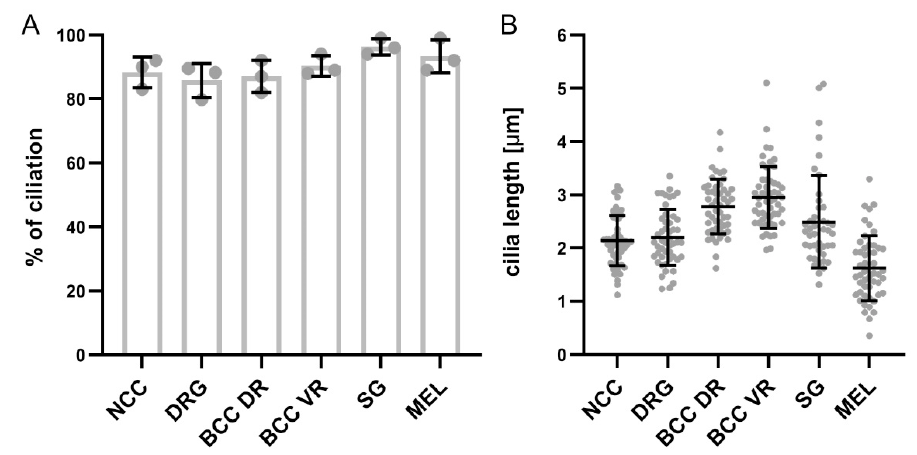
Figure 5. Quantification of the percentage of ciliated cells and ciliary length in NCCs and their derivatives. ( A ) Graph showing the average percentage of ciliation in migrating NCCs at HH18 and NCC derivatives at HH26. Note that for DRG, the average percentage of Hoechst-positive cells bearing a cilium is shown. ( B ) Graph showing the average cilia length in migrating NCCs at HH18 and NCC derivatives at HH26. Error bars represent standard deviation. Data points represent the average percentage for each embryo ( A ) and single data points of cilia length that were measured ( B ), respectively. DR, dorsal roots; VR, ventral roots, MEL, melanocytes.